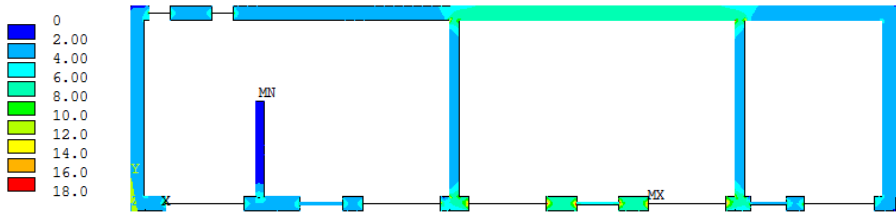
Figure 9. Heat flux through the walls under the free convection simulation.